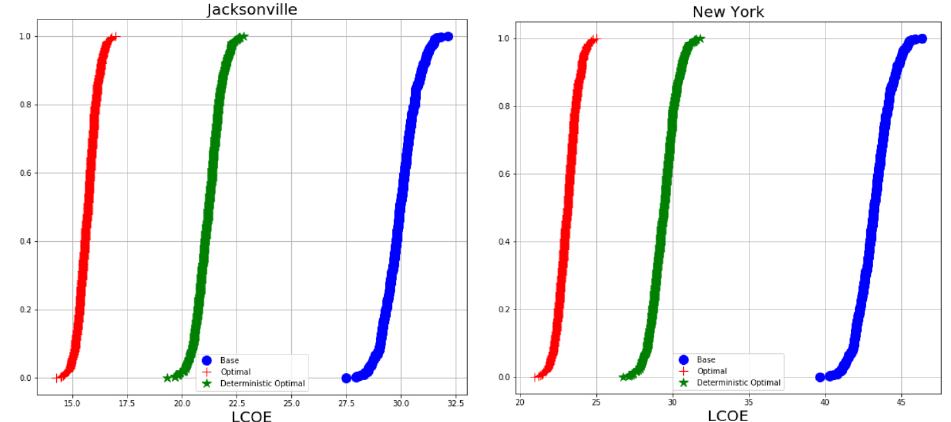
Figure 10. Comparing the CDF of LCOE at the base, deterministic optimal, and stochastic optimal for 450 Jacksonville and New York. 451